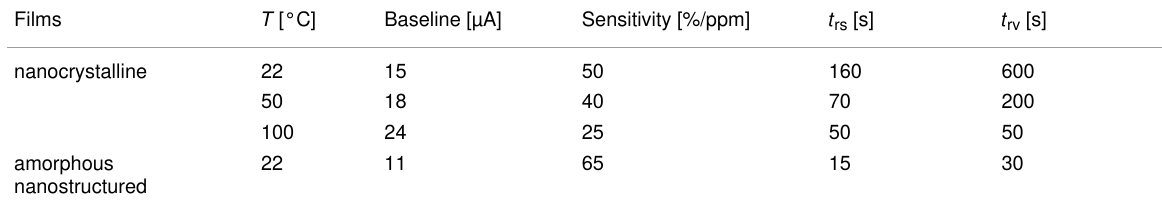
Table 1: Gas-sensing parameters of nanostructured Te films. t rv is the recovery time and t rs is the response time upon exposure to 1.0 ppm of NO 2 . Films